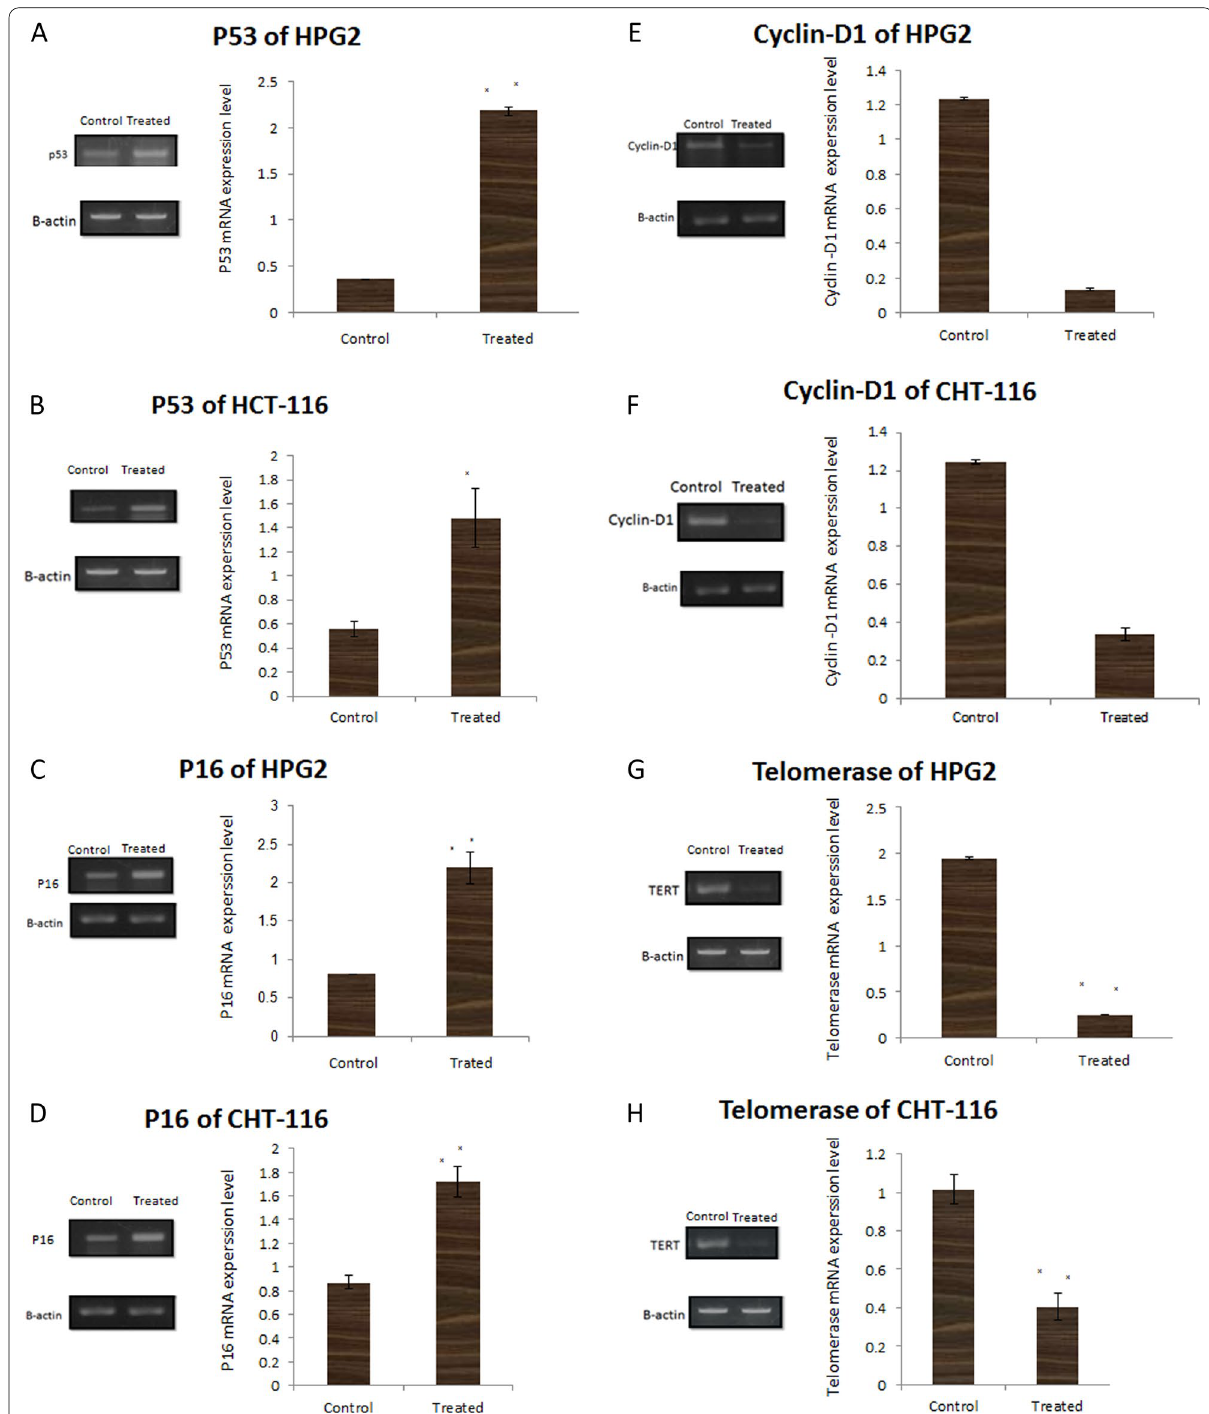
Fig. 3 PCR detected the expression of p53, p16, cyclinD1, and TERT in HepG2 and HCT‑116 cells after treatment with NSP where the internal control expressed by the β‑actin gene. In each illustrative experiment data represent means dissimilar results (P <